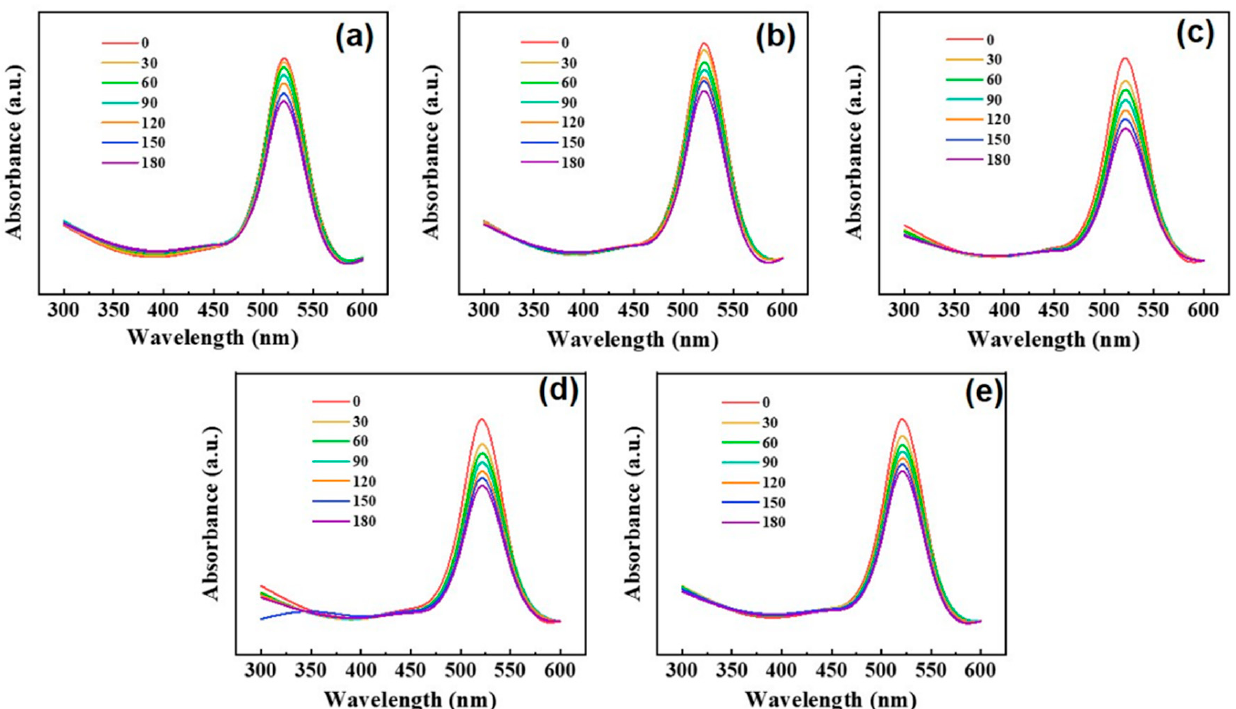
Figure 4. Absorption spectral pattern of ( a ) control and ( b – e ) MB during photocatalytic degradation process in the presence of LC-ZnO/OF under visible light irradiation.